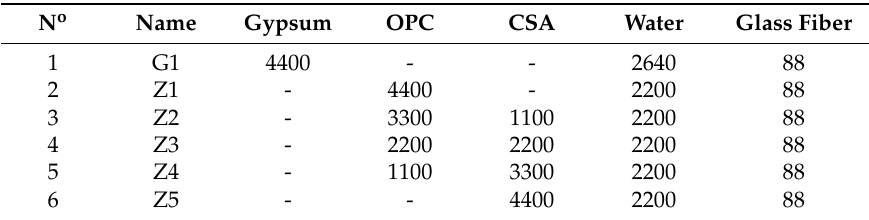
Table 4. Ingredients compounds (g).